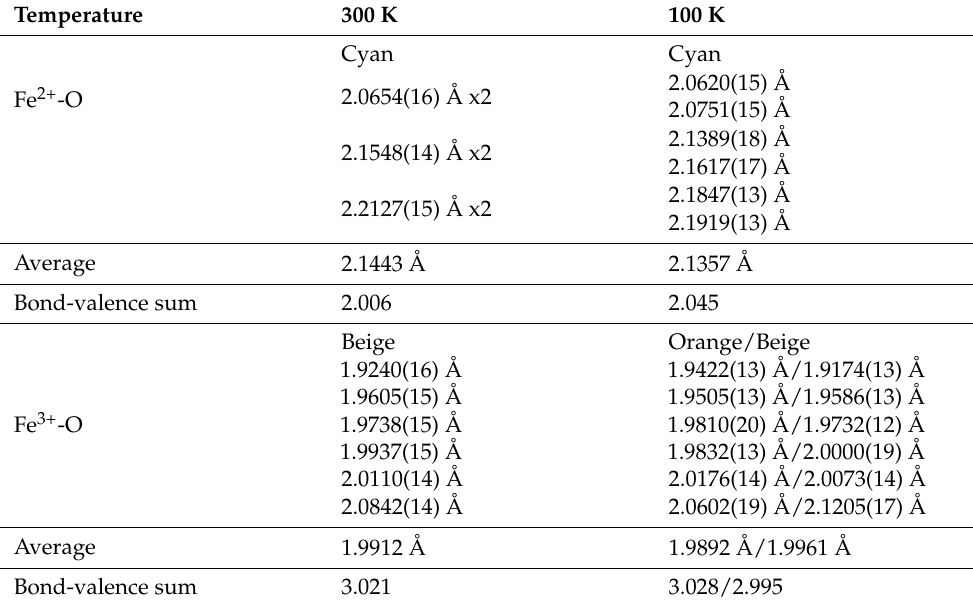
Table 4. Bond-lengths and bond-valence sums within FeO 6 octahedra for the crystal structures obtained from the X-ray laboratory measurements with the lattice parameters given in the last two columns of Table 1 and atomic coordinates given in Tables 2 and